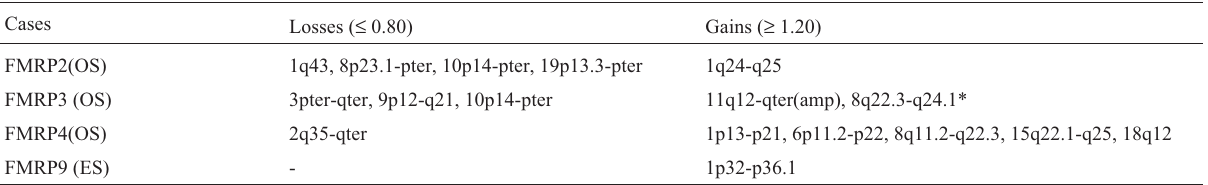
Table 2 - Chromosomal imbalances detected by CGH in three osteosarcomas (OS) and one Ewing’s sarcoma (ES).